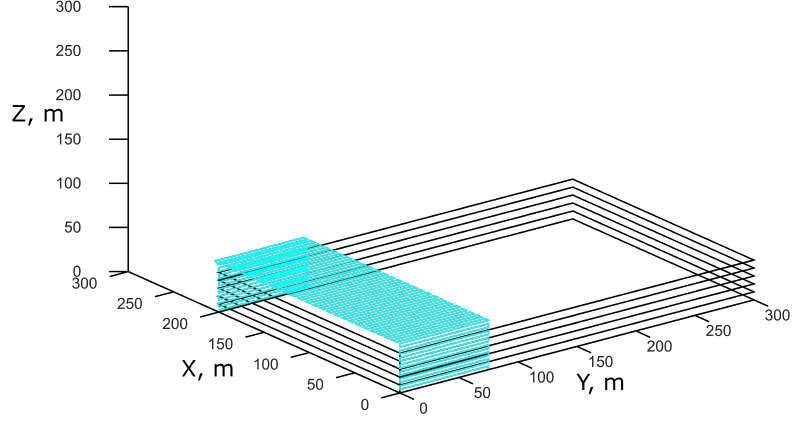
Figure 5. Trajectory around a building 300 × 200 × 50. All axes in the same